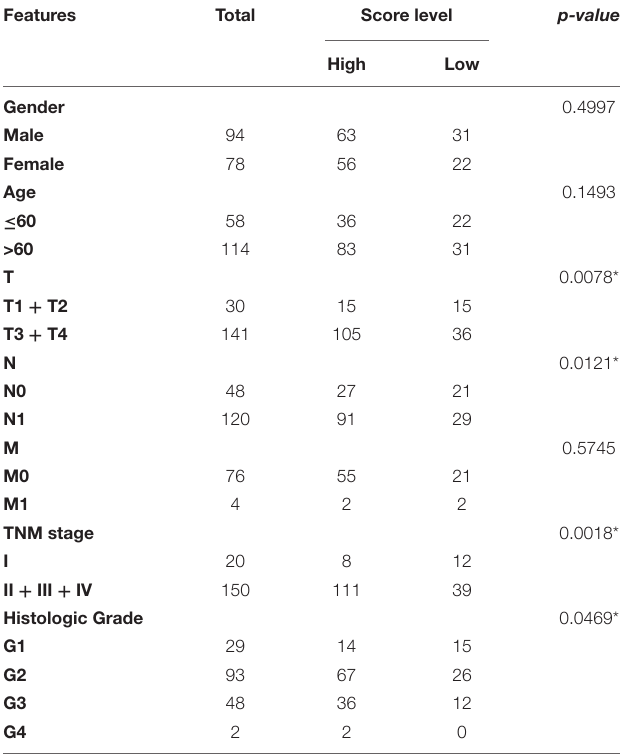
TABLE 1 | The association of the immune signature with clinicopathological characteristics in TCGA database.